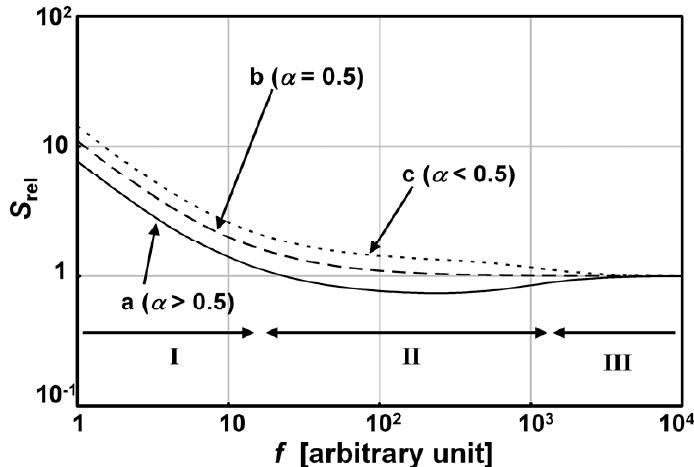
Fig. 1 Calculated relative noise spectra for illustration in the case when the electrode is polarized far away from equilibrium (the charge transfer process practically takes place only in one direction). Curve a, b, c show three different possibilities according to the value of the charge transfer coefficient, namely α > 0.5 (curve a ), α = 0.5 (curve b ), α < 0.5 (curve c ). In frequency region I the flicker noise dominates the relative noise spectra, in frequency region II the charge transfer process, while in region III the solution